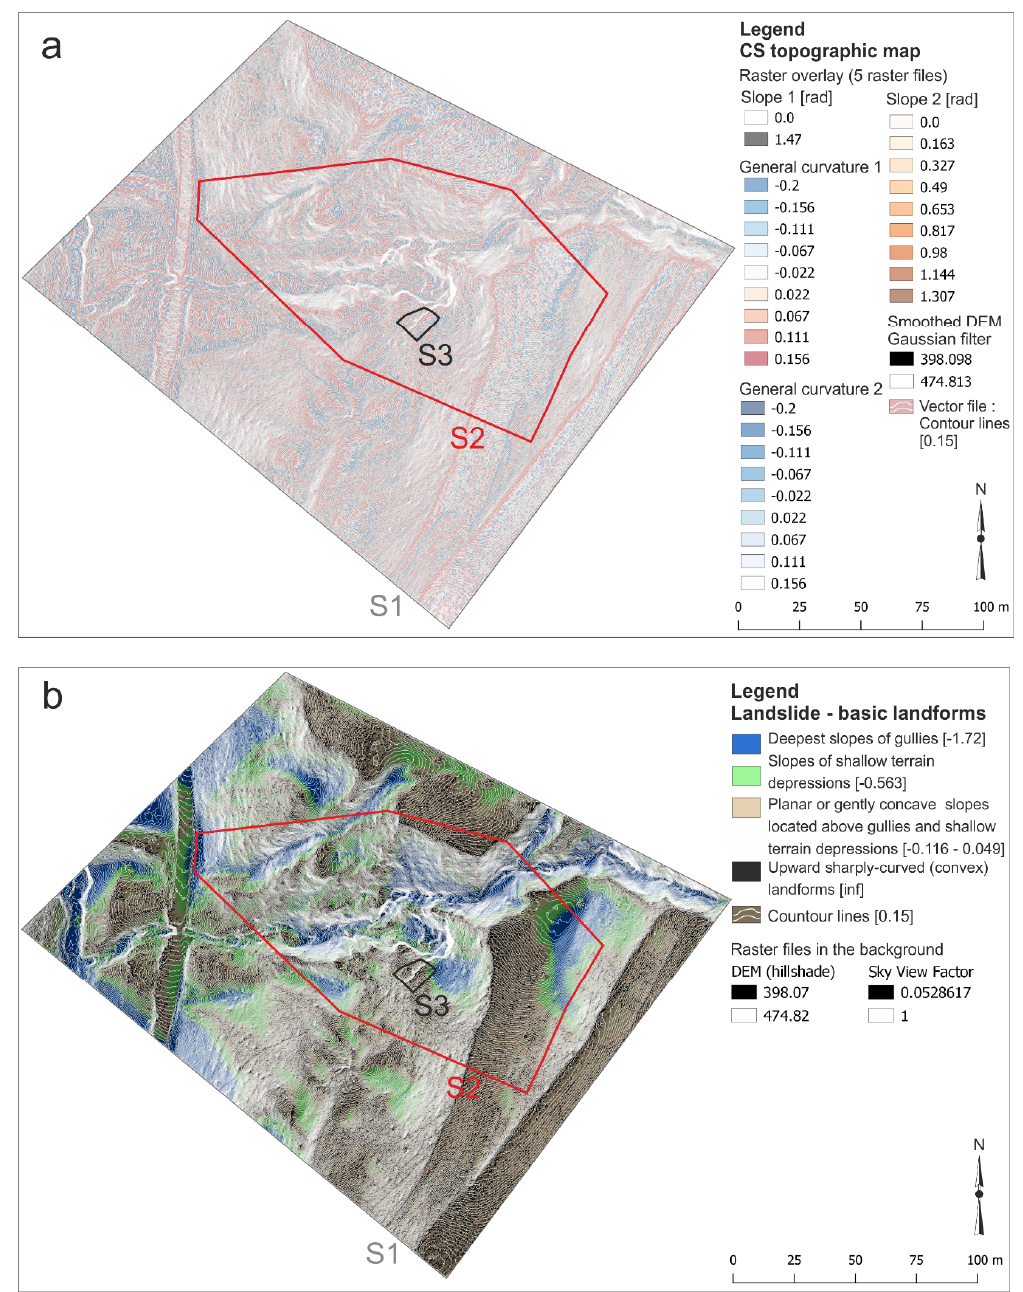
Figure 3. Delineation of a gully related landslide system in a digital elevation model (DEM) generated from point clouds acquired by aerial laser scanning using the LiDAR technology applying the ( a ) CSMapMaker QGIS plugin and ( b ) Raster operation. The depth of valleys was deducted from multiplied raster files of maximal curvature and sky-view factor, and the output raster indicates basic landforms of the investigated landslide.